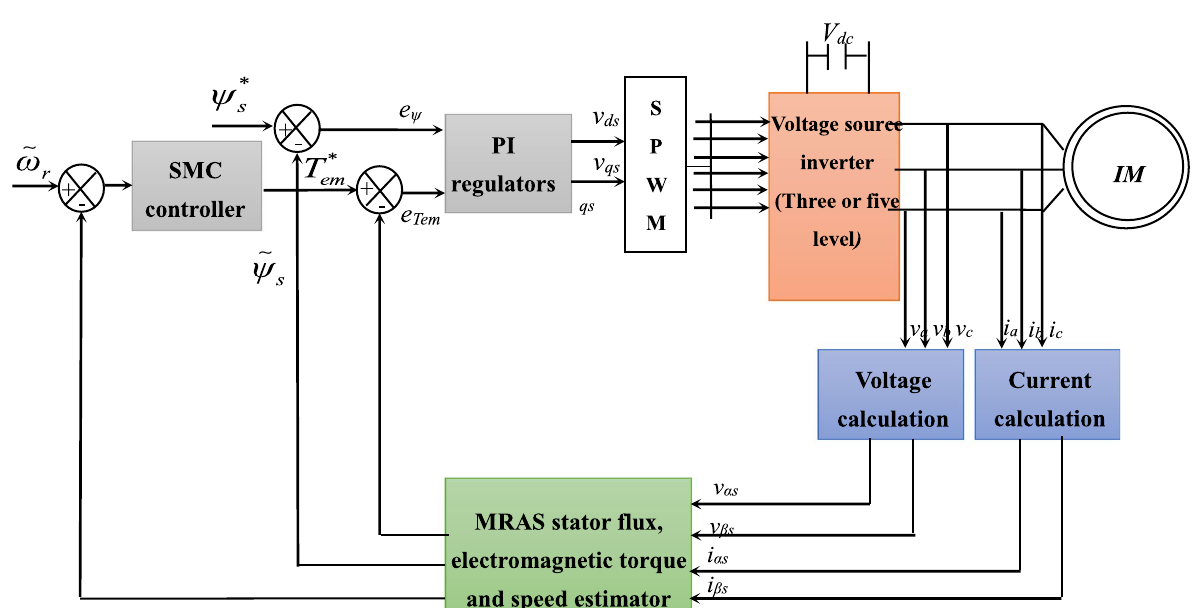
Fig. 5 Improved DTC strategy based on SPWM and PI regulators by powering the motor with multilevel inverter